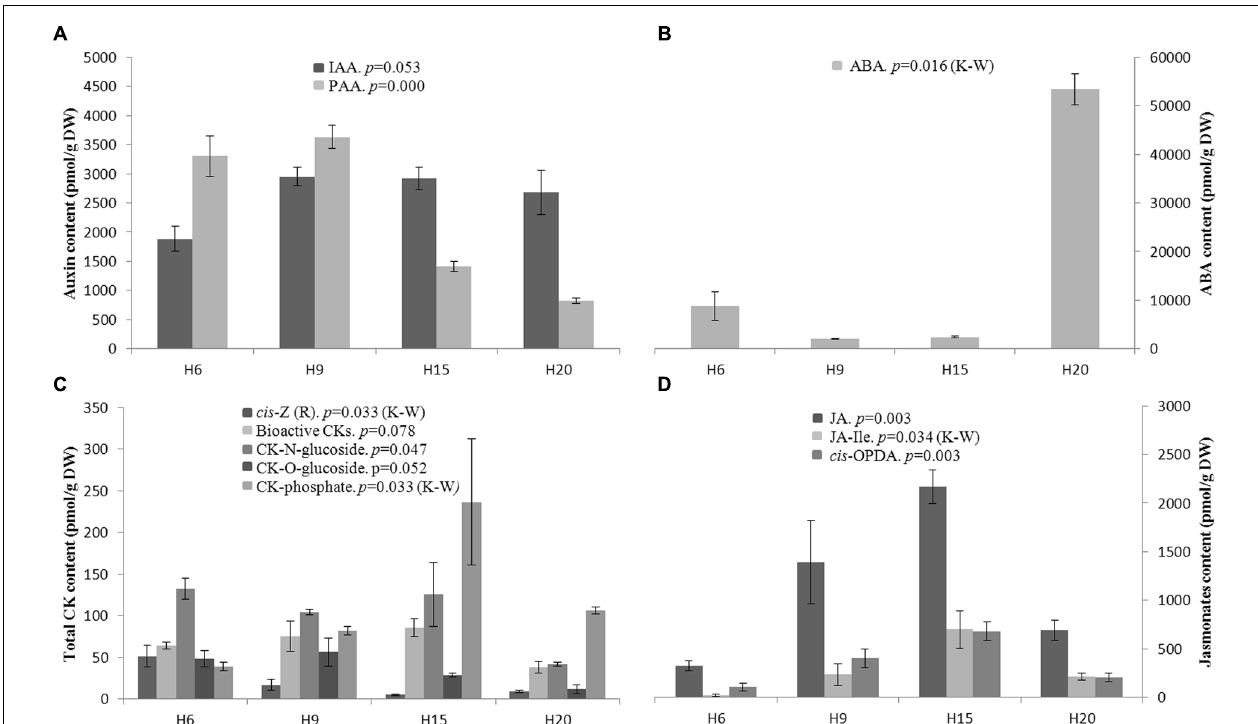
FIGURE 8 | Endogenous phytohormone levels in hemp hypocotyls at H6, H9, H15, and H20. (A) (top left): bioactive auxins; IAA indole-3-acetic acid, PAA phenylacetic acid. (B) (top right): ABA, abscisic acid. (C) (bottom left): Total cytokinin. (D) (bottom right): bioactive JAs; JA, jasmonic acid; JA-Ile, jasmonoyl-isoleucine; cis -OPDA, cis -( + )-12-oxo-phytodienoic acid. Mean values ± SE are given. ANOVA or Kruskal–Wallis (K–W) results are indicated depending on the normality of data distribution (Shapiro–Wilk p > 0.05 or p < 0.05, respectively). n = 3 biological replicates.